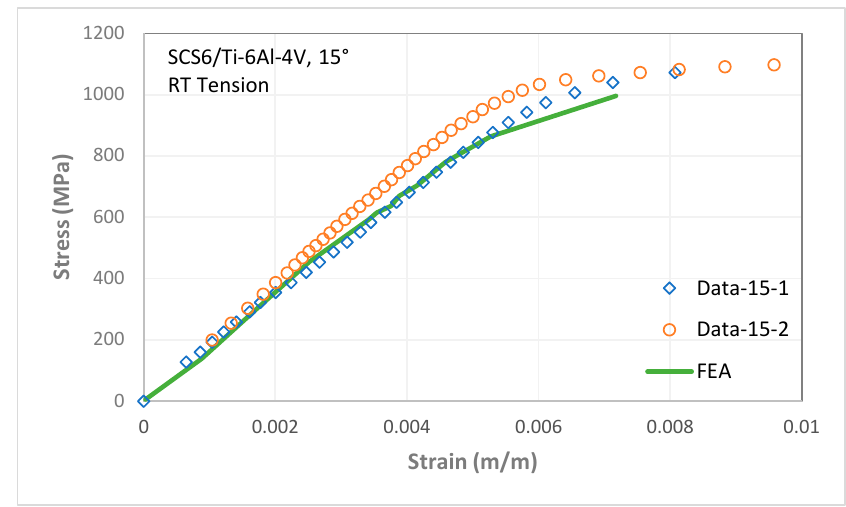
Figure 9. Stress-strain response for 15° off-axis at 23 °C.